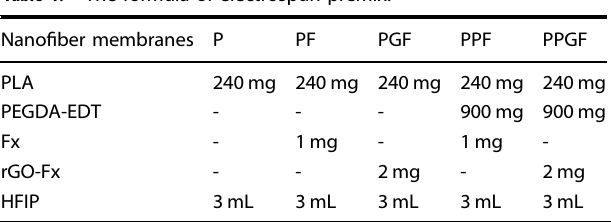
Table 1. The formula of electrospun premix. Nano fi ber membranes